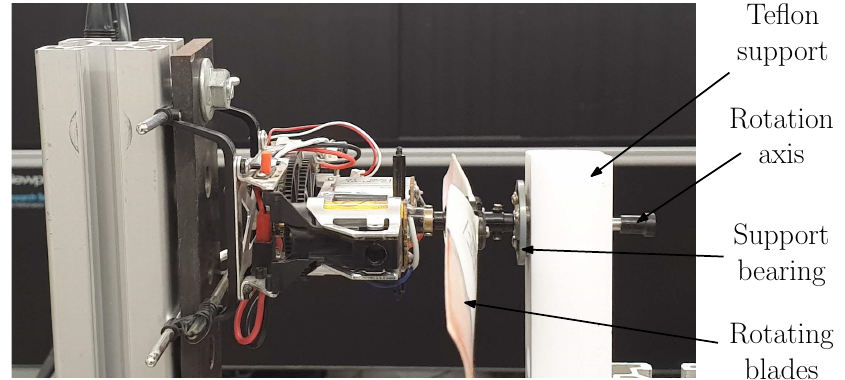
Figure 19. Stabilization of the RC helicopter’s axis, using a bearing and a support built out of teflon. For the present work, the objective centres around the structure’s response and not the fluid’s. Nonetheless, the air velocity in stationary frame at the final instant of the CFD simulation is shown in Figure 20 as an example.